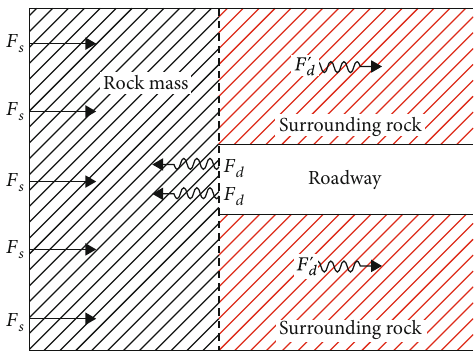
Figure 1: Schematic diagram of the surrounding rock forces during tunnel excavation ( F s : static stress, F d : dynamic load, and F d ′ : dynamic